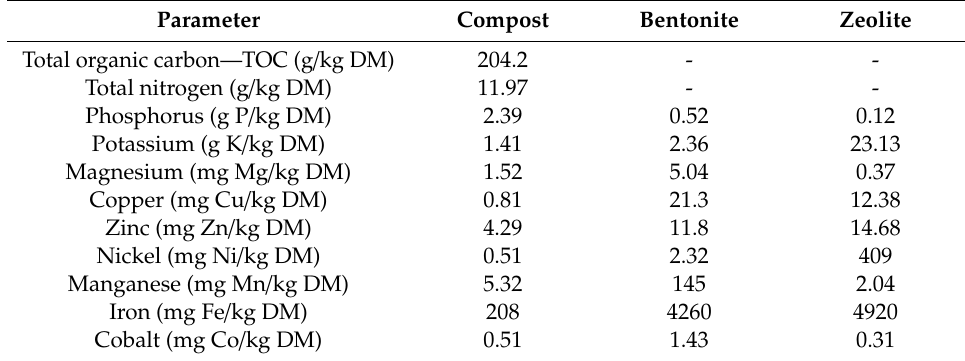
Table 2. Properties of